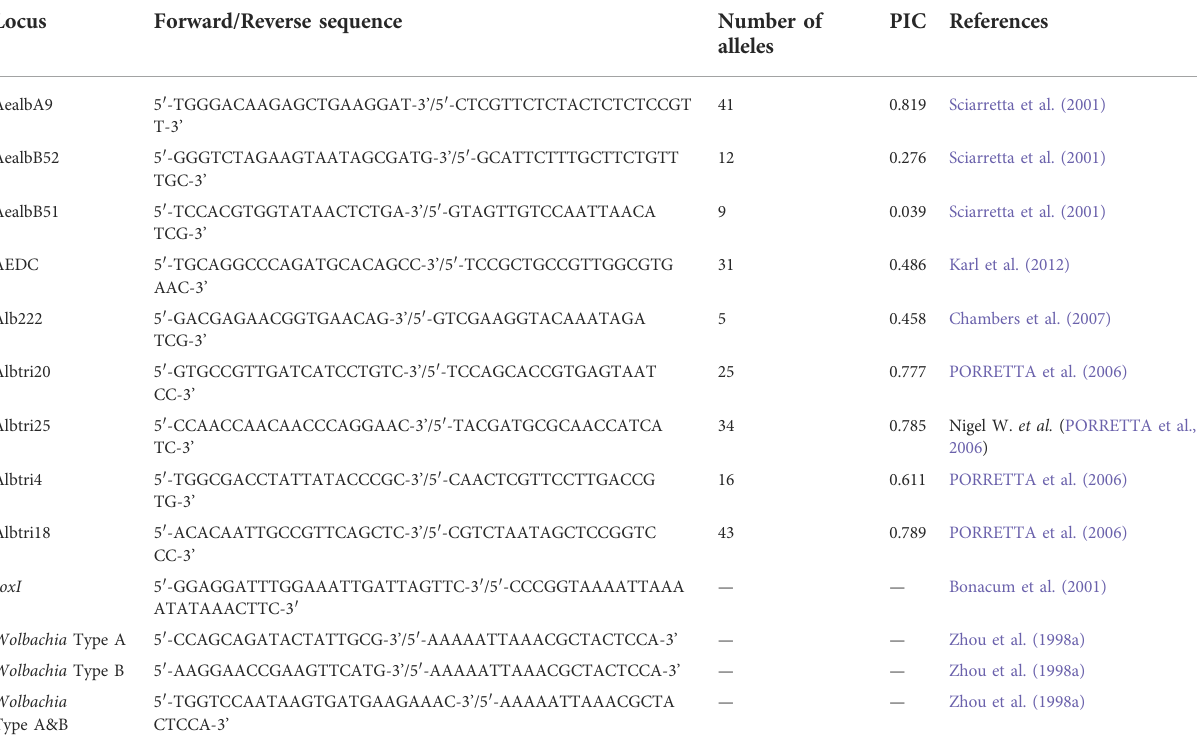
TABLE 2 Microsatellite primers and Wolbachia detection primers used to genotype Ae. albopictus specimens sampled from different regions of Nanjing City. Locus Forward/Reverse sequence Number of